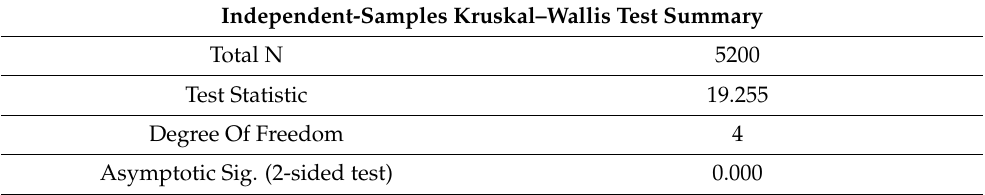
Table 7. Results of Kruskal–Wallis one-way ANOVA on ranks test for model predictions. Independent-Samples Kruskal–Wallis Test